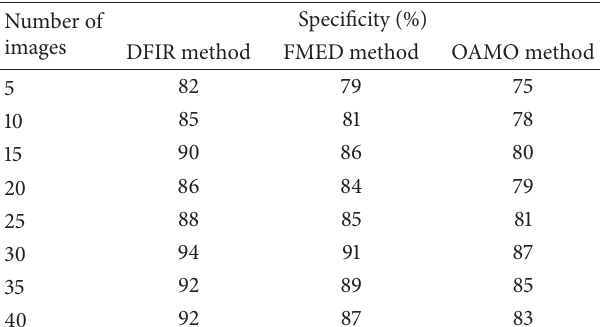
Table 2: Tabulation for specificity.